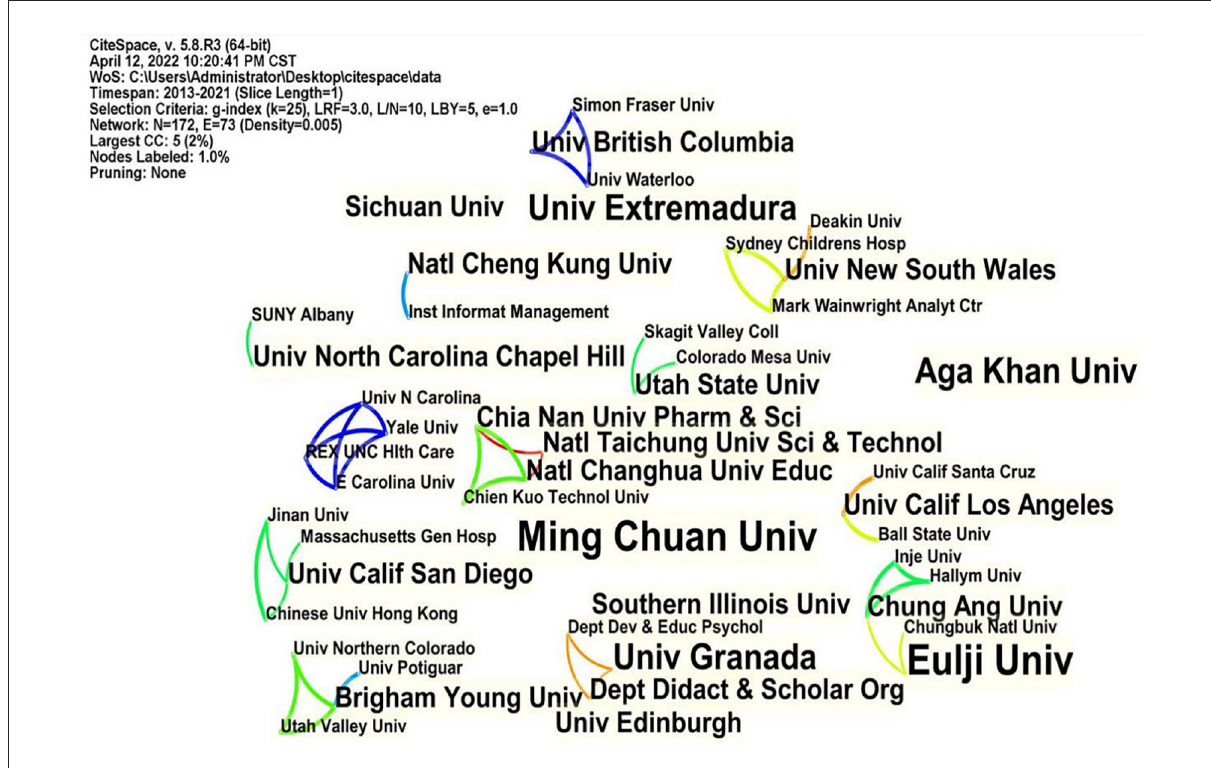
FIGURE4 Research institutions mapping knowledge domains.